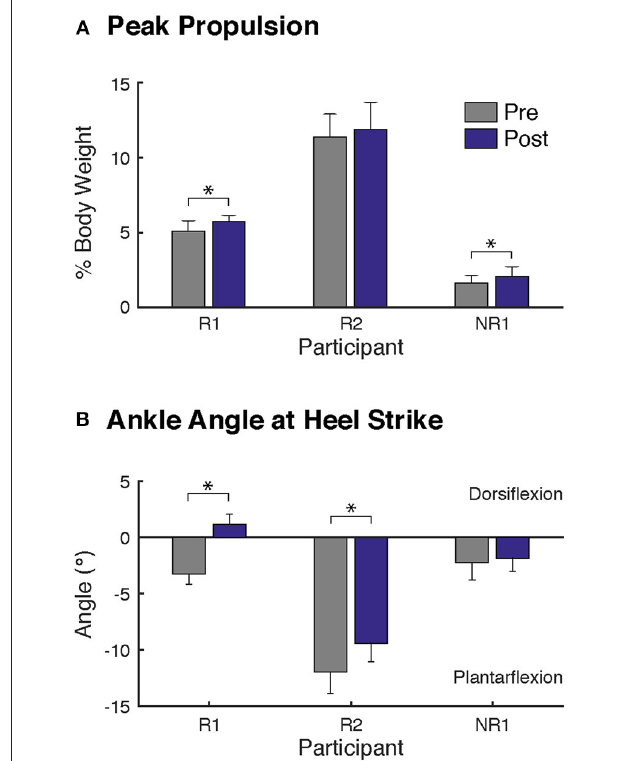
FIGURE 1 | Changes in biomechanics at self-selected walking speed after FastFES. Two biomechanical outcomes were analyzed, consistent with the biomechanical parameters targeted by plantarflexor and dorsiflexor FES, (A) peak paretic propulsion, defined as peak anterior ground reaction force during stance, and (B) the paretic ankle angle at heel-strike, where positive values correspond to dorsiflexion. Participants R1 and NR1 demonstrated significant increase in paretic leg propulsion after FastFES (A) . Both responders (Participants R1 and R2) walking with greater dorsiflexion ankle angles at heel-strike after FastFES (B) . Note that to prevent the influence of changes in speed on gait biomechanics, the post-training evaluation was conducted while participants walked at their pre-training self-selected speed. (* denotes p ≤